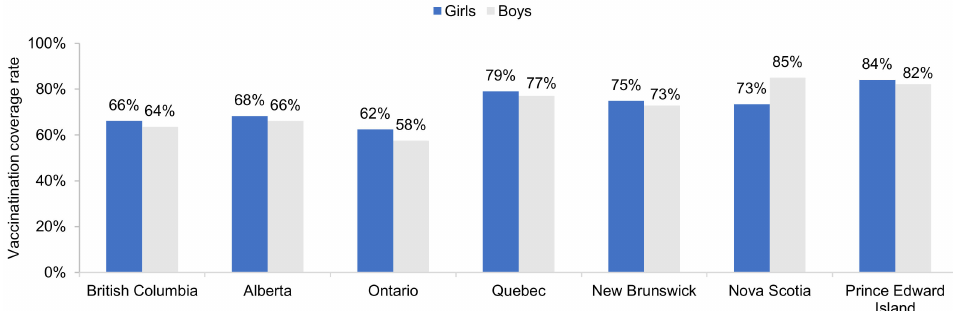
Figure 3. Most recent HPV vaccination coverage rates in schoolgirls and schoolboys, by province. Shown are the most recent data only for provinces with vaccination of both girls and boys. Data are for 2016 / 17 for Nova Scotia. Data are for 2017 / 18 for Alberta and Ontario. Data are for 2018 / 19 for British Columbia, Quebec, New Brunswick, and Prince Edward Island. Source: Canadian Partnership Against Cancer System Performance and provincial health authorities